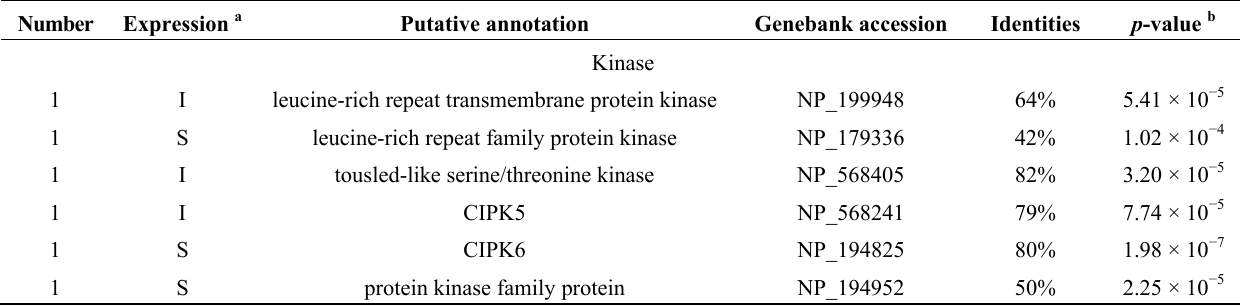
Table 3. Signal elements involved in salt stress